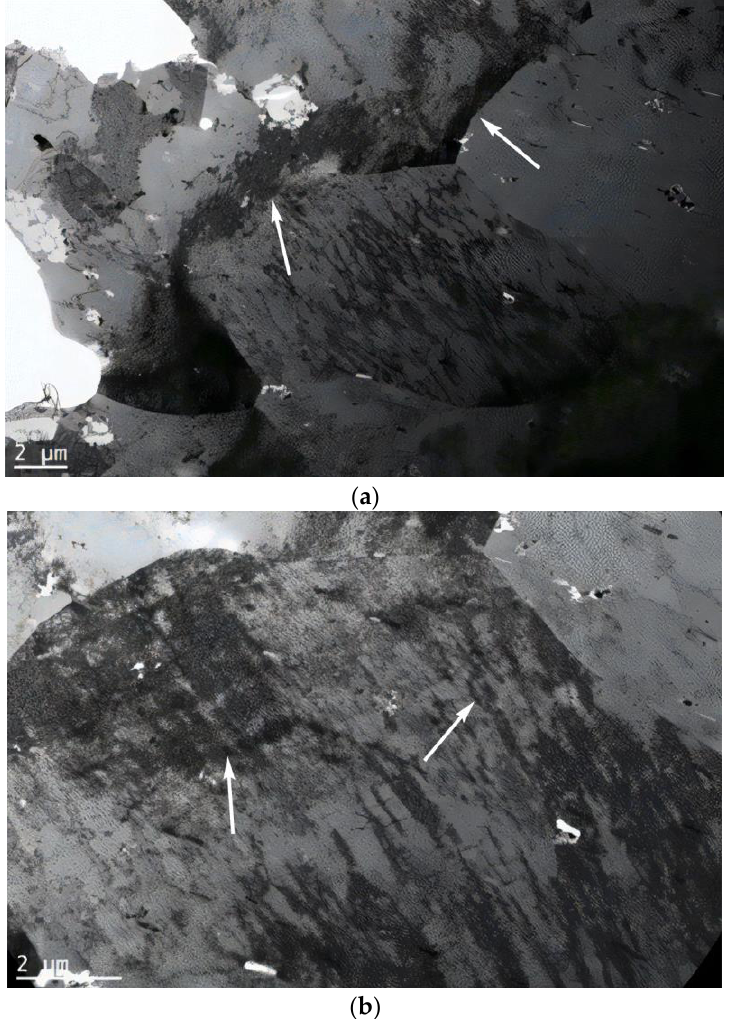
Figure 10. TEM — ( a , b ) the structure of alloy D16ChATW afte r DNP (ε imp = 6.69%); Arrows show Figure 10. TEM—( a , b ) the structure of alloy D16ChATW after DNP ( ε imp = 6.69%); Arrows show the the formation of hydrodynamic flow channels and block structure zones. formation of hydrodynamic flow channels and block structure